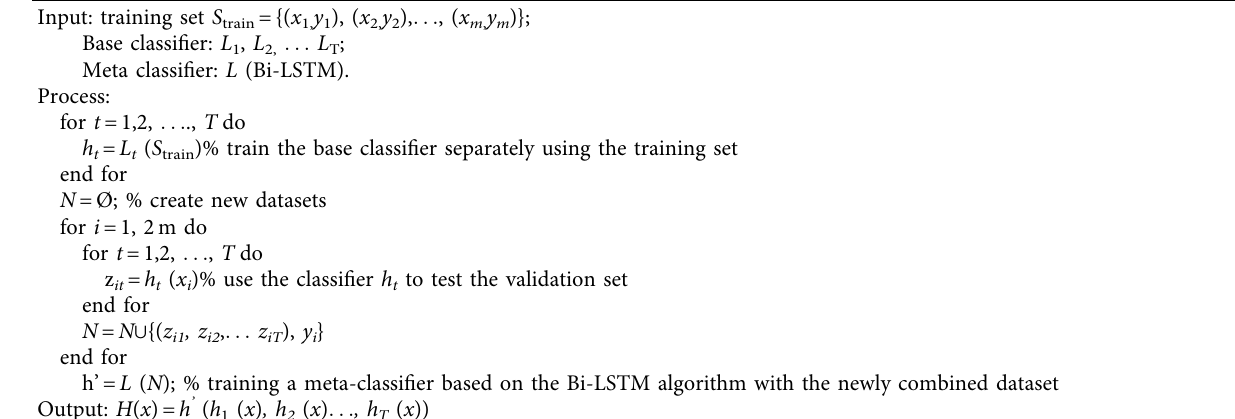
Figure 3: Stacking ensemble learning architecture: the data are divided into the training set and the test set. Te training set is divided into four training subsets and one validation subset, and a new subset is obtained by the basic classifer RF, SVM, LSTM, and AT Bi LSTM. Te new subset is trained by the meta-classifer to obtain the pedestrian crossing intention recognition model. Similarly, the new test set is obtained by four base classifers. Te test set is input into the intention recognition model to obtain the fnal recognition accuracy. Table 1: Pseudocode of the stacking